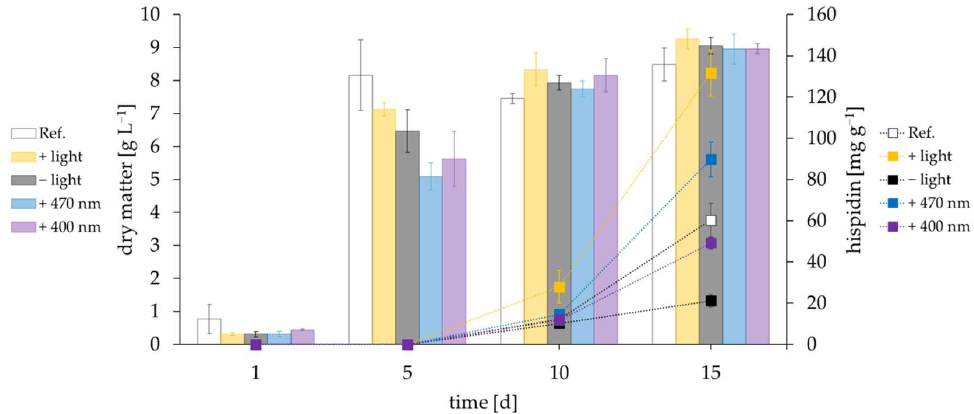
Figure 1. Biomass (bars, left ordinate) and hispidin yields (squares, right ordinate) of differently irradiated cultures of I. hispidus . Cultures were either kept in the dark (− light, depicted in black/gray) or irradiated with LEDs, specified as 400 nm (purple), 470 nm (blue), and white light (+ light, depicted in yellow). The reference culture (Ref., depicted in white) was cultivated in an incubator with a glass window, but without specific light regulation.